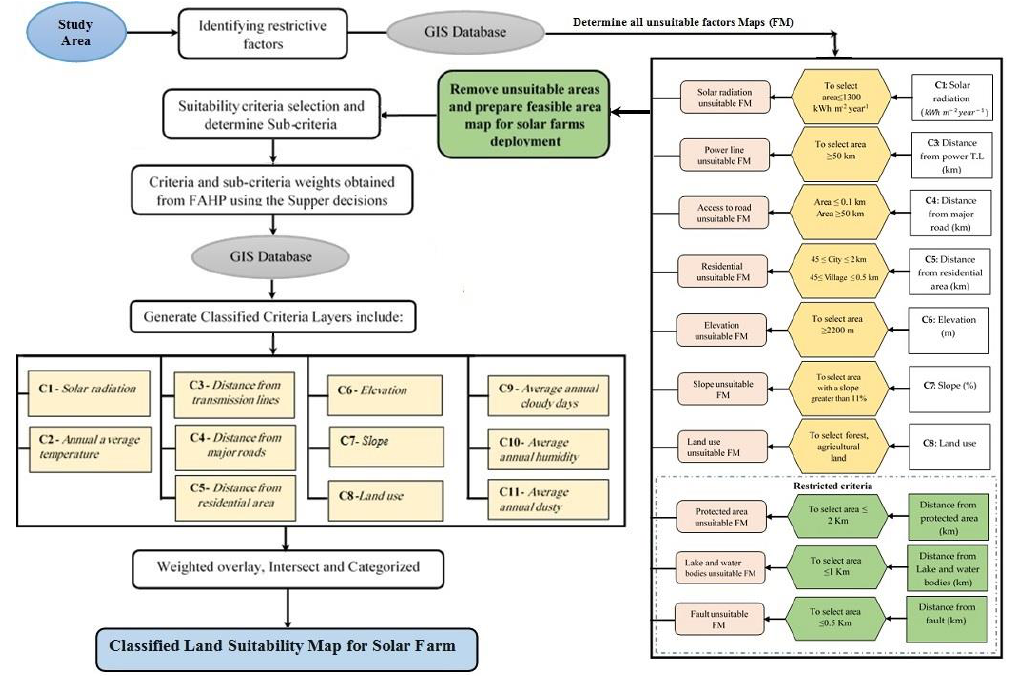
Figure 4. The conceptual model of the proposed framework.